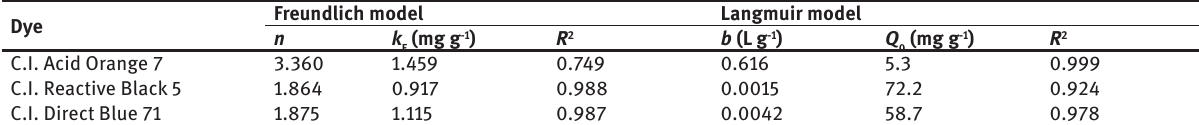
Table 5: Langmuir and Freundlich isotherm parameters for the sorption of acid, reactive and direct dyes on the aminosilane modified silica.